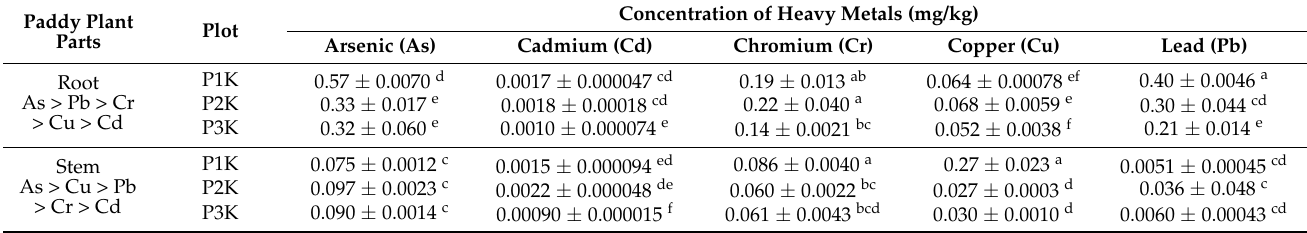
Table 2. Concentration of heavy metals in paddy plants collected from